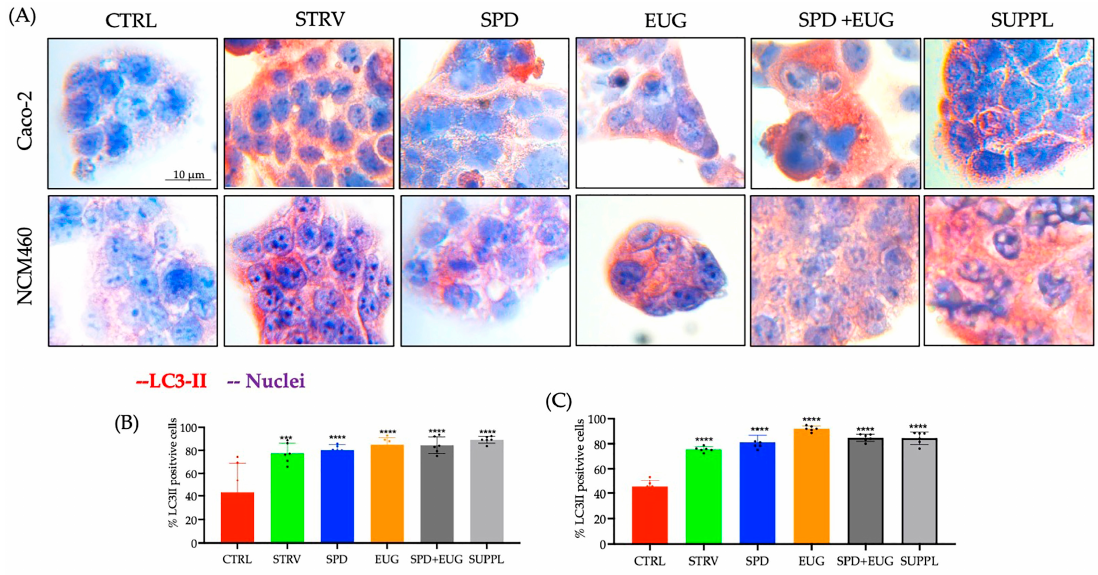
Figure 2. The effect of 1.2 µM spermidine (SPD) and 0.2 mM eugenol (EUG) alone, in combination (1.2 µM SPD + 0.2 mM EUG), and in supplement (SUPPL) form (1.2 µM SPD + 92 µM EUG), respectively, on LC3-II activation in Caco-2 ( A , B ) and NCM460 ( A , C ) cell lines compared to the untreated control (CTRL). ( A – C ) LC3-II expression in the CTRL, the starvation (STRV)-induced control, and all treatments was detected with red chromogen staining after 4 h and visualized at ×40 magnification. ( B , C ) Statistical analysis of the LC3-II positive cells stained with red chromogen was performed with significant differences represented as follows: *** 0.0001 < p < 0.001, **** p < 0.0001. The black dots indicate the positioning of the individual replicates within the bar for each sample.